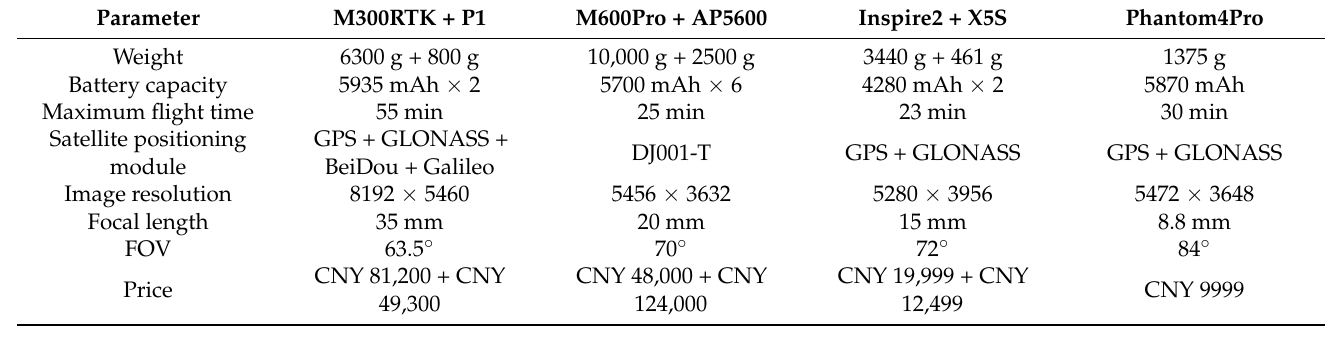
Table 1. Performance parameters of four UAVs and PTZ cameras.